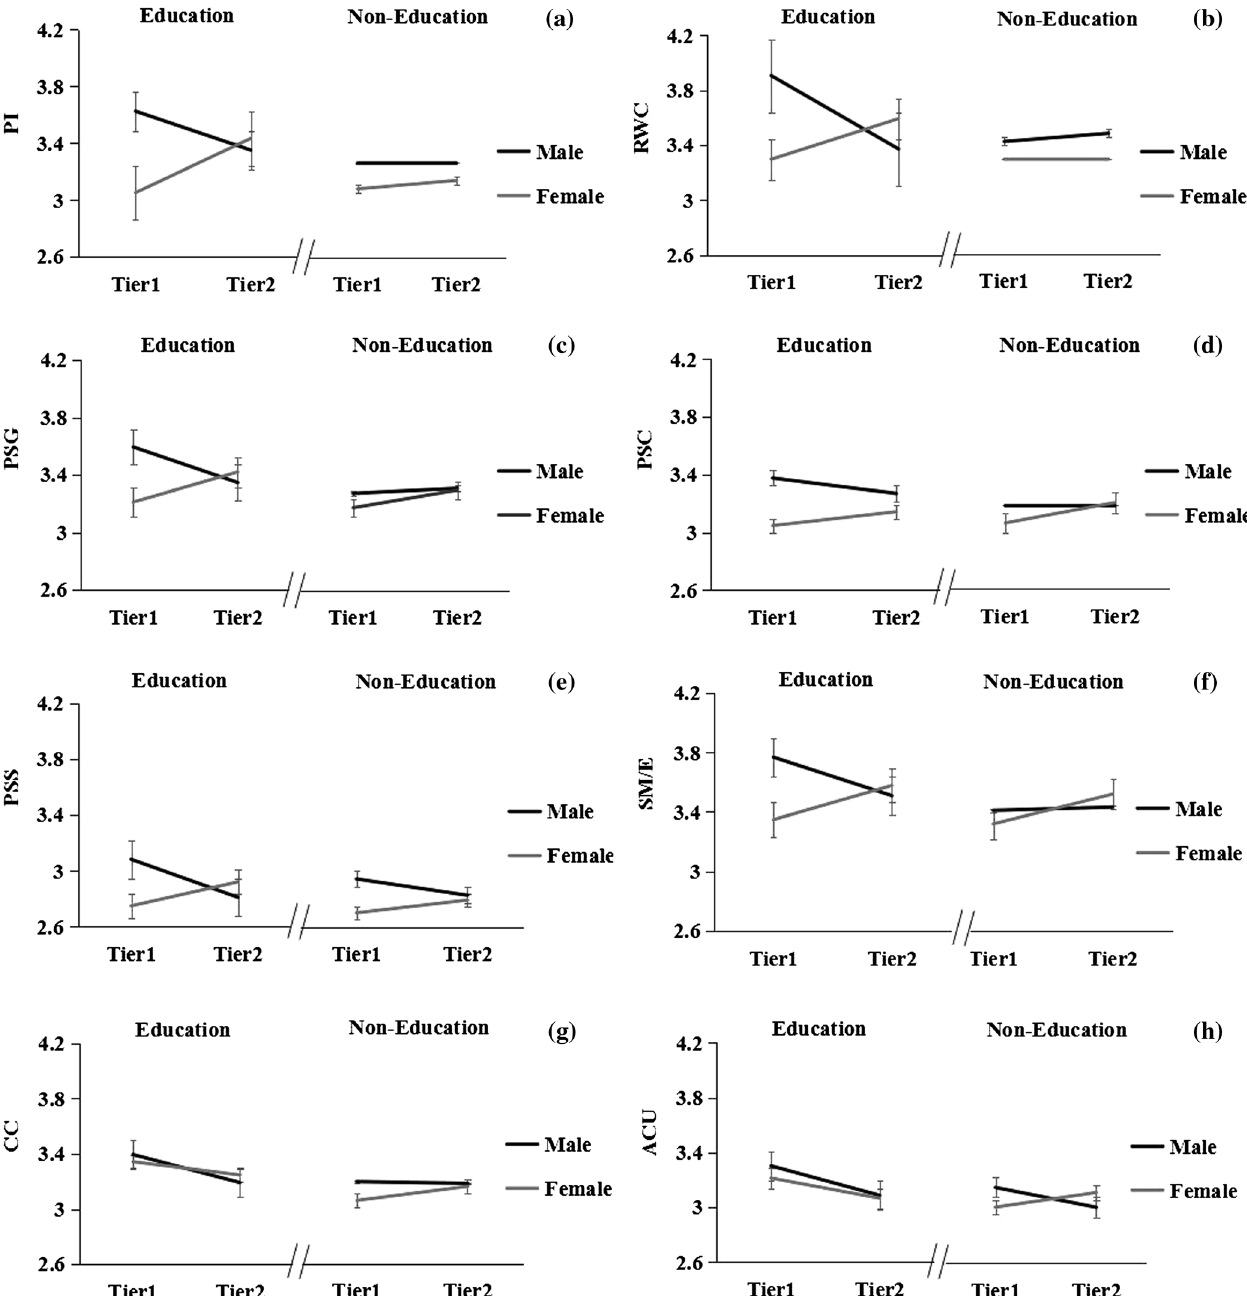
FIG. 2. Categories of epistemological beliefs towards physics learning measured by the CLASS. (a) personal interest (PI), (b) real world connection (RWC), (c) problem solving general (PSG), (d) problem solving confidence (PSC), (e) problem solving sophistication (PSS), (f) sense making/effort (SM = E), (g) conceptual connections (CC), and (h) applied conceptual understanding (ACU). Each data point represents the average score of each group. Error bars represent standard